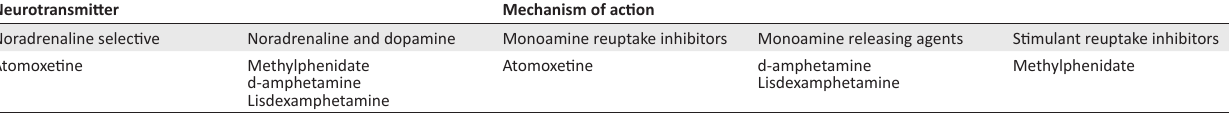
TABLE 1: Pharmacological classification of medication used for the treatment of ADHD.